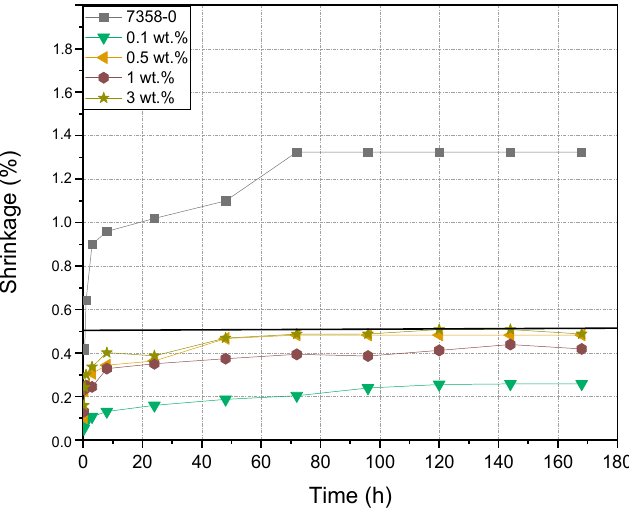
Figure 13. Influence of palygorskite addition on shrinkage Si-PSA.